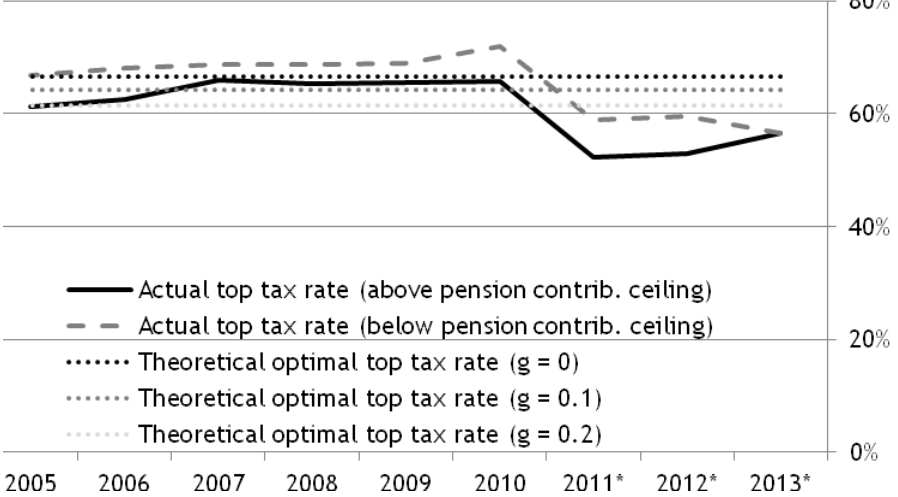
Figure 2. Actual effective top tax rates in Hungary,